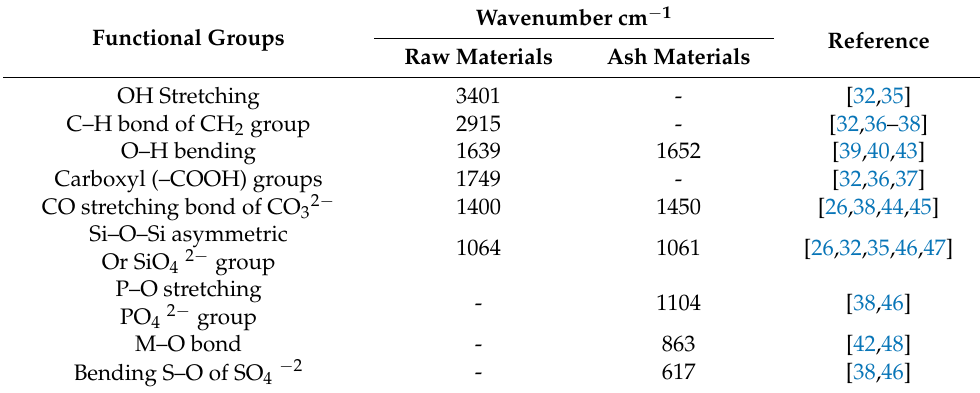
Table 3. FTIR spectra assignment for raw and ash